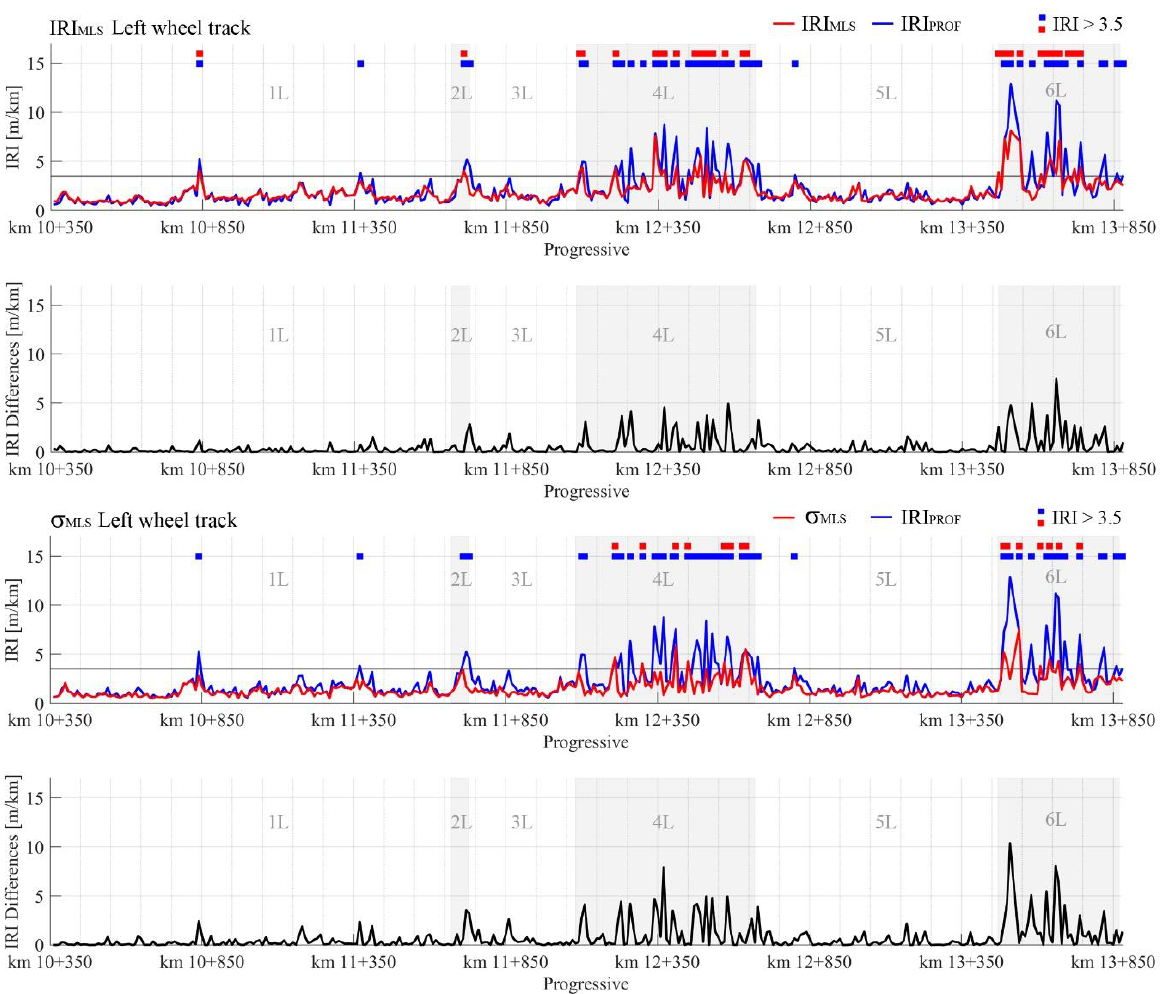
Figure 7. Left wheel track. Comparison between roughness indices: International Roughness Index computed using data by mobile laser scanner (IRI MLS ) and standard deviation of longitudinal roughness (σ) computed using data by mobile laser scanner (σ MLS ) vs. inertial profilometer (IRI PROF ).